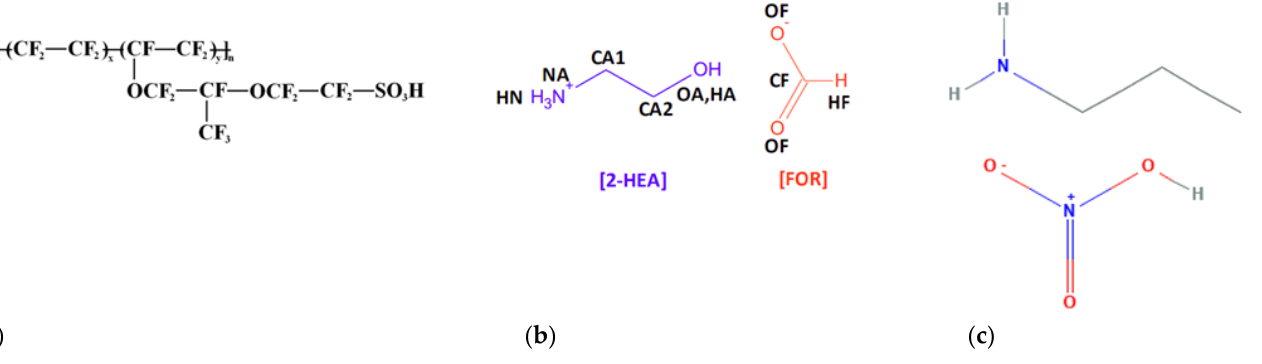
Figure 1. Chemical structure of ( a ) Nafion ® 112, ( b ) 2-HEAF and ( c ) PAN.